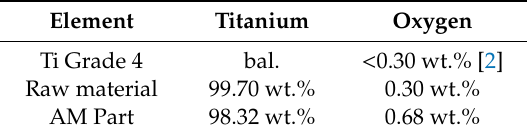
Table 1. Oxygen content of the base material analyzed by inert gas fusion.